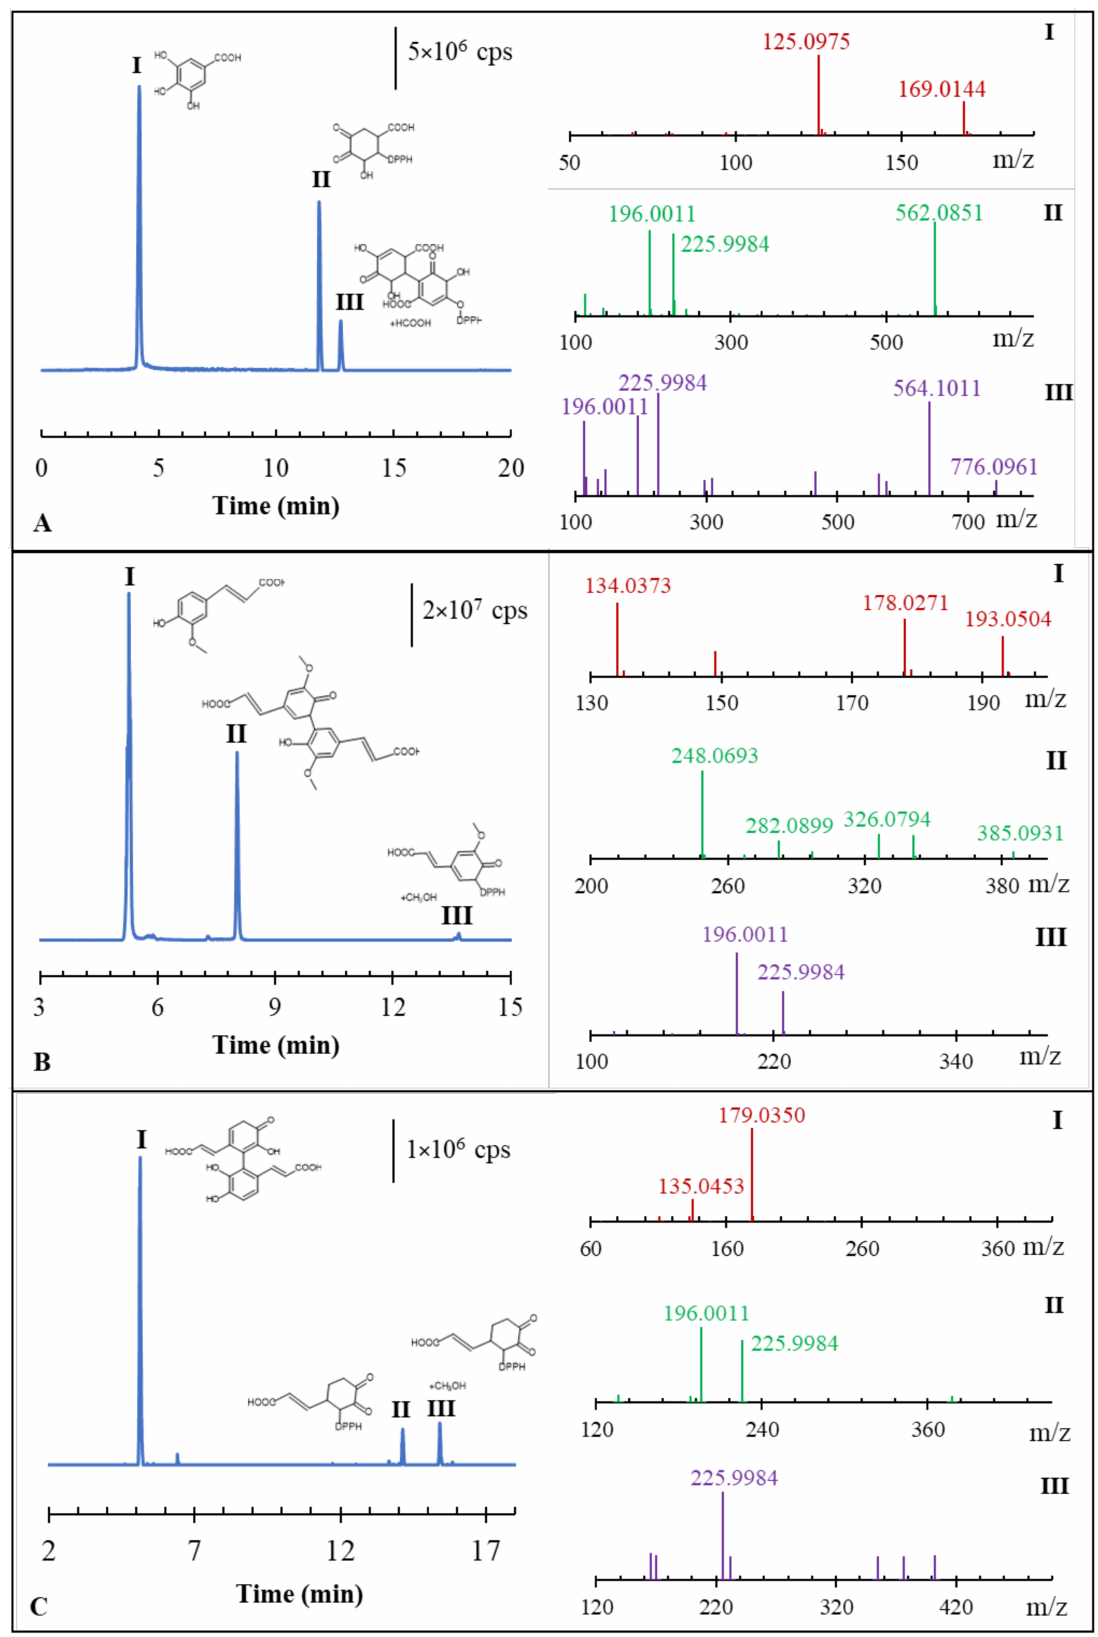
Figure 3. Extracted ion chromatographic peaks with the corresponding proposed molecular formulas for gallic ( A ), ferulic ( B ) and caffeic acid ( C ) after the reaction with DPPH • . On the right, the dd-MS 2 spectra presenting the characteristic fragment ions are